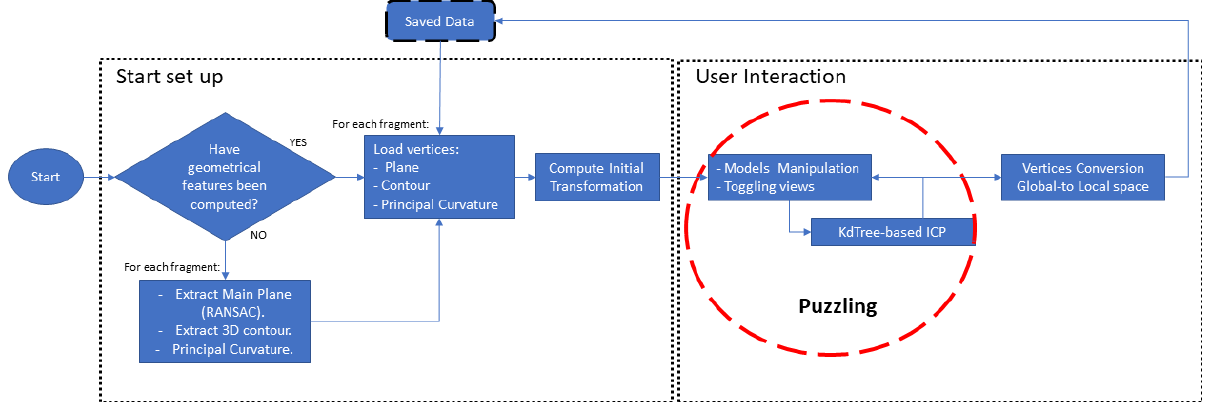
Figure 2: Methodology work-flow for the Puzzling Engine. The starting setup is performed for each fragment of the set. The Puzzling stage refers to pairwise alignment. Both are implemented on the game engine Unity . 3.1.2 Contour Surface The Probability of finding matches is higher for the contour points of the plane. By segmenting this area, the user is able to find potential visual clues of possible matches and to perform either automatic or manual alignment.